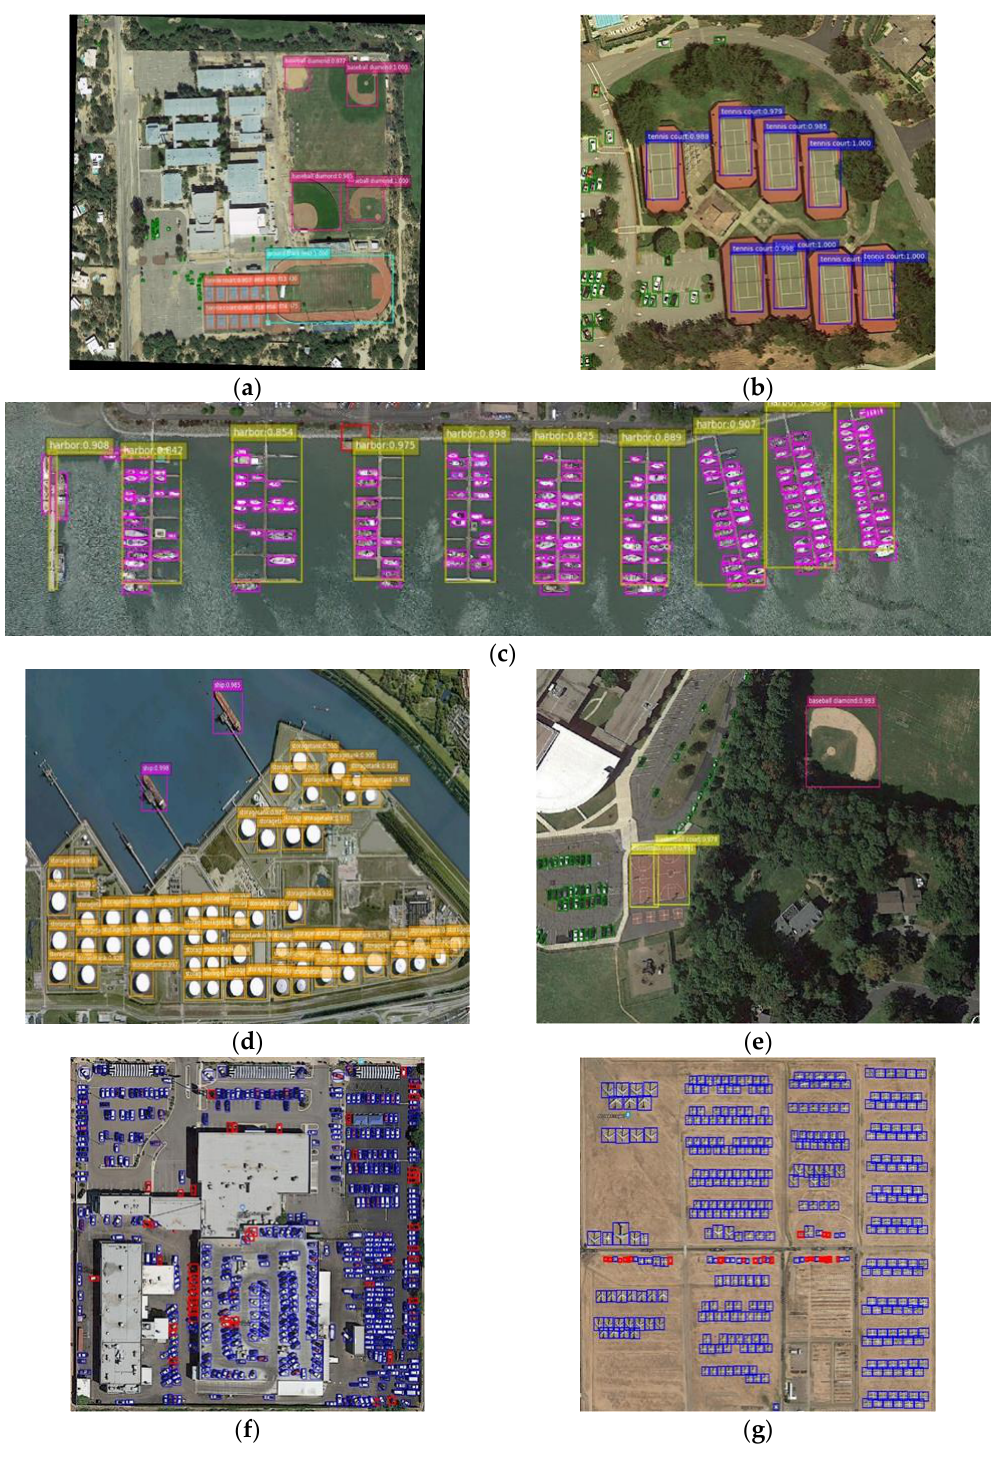
Figure 12. Detection results on large-scale remote sensing images. ( a ) Baseball diamond, ground track filed, tennis court, and vehicle; ( b ) vehicle, and tennis court; ( c ) harbor, and ship; ( d ) storage tank, ship; ( e ) baseball diamond, basketball court, and vehicle; ( f ) vehicle; and ( g ) airplane.